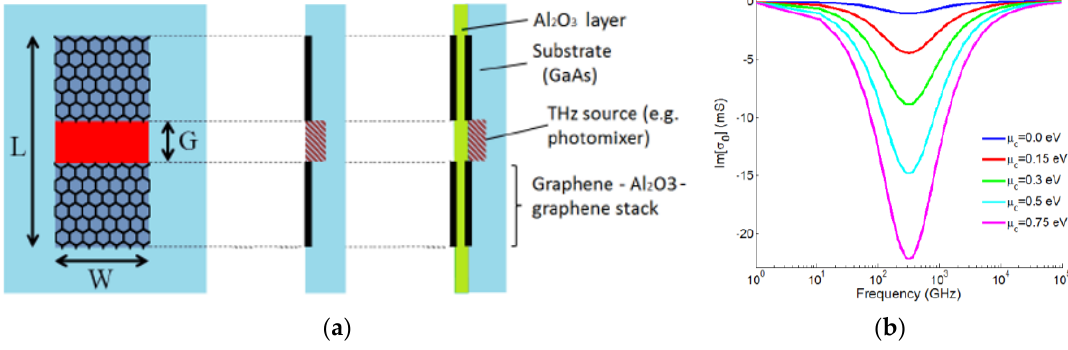
Figure 1. Real ( a ) and imaginary ( b ) parts of graphene conductivity versus chemical potential. Graphene parameters are τ = 0.5 ps and T = 300 °K [5]. (With permission from IEEE).